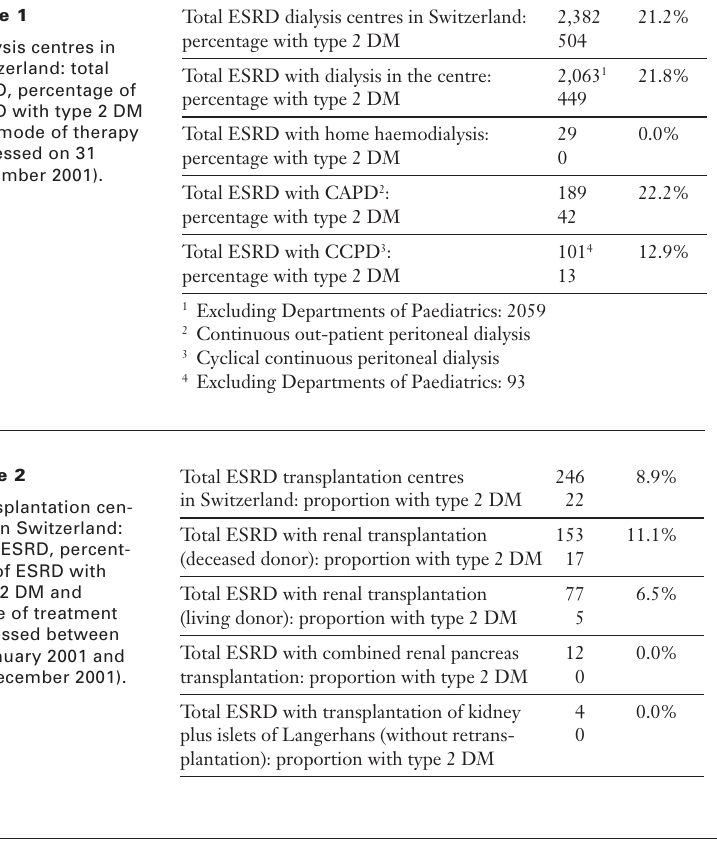
Total ESRD (dialysis and transplantation centres); classifica- tion into the three modes of therapies (absolute and in %) and